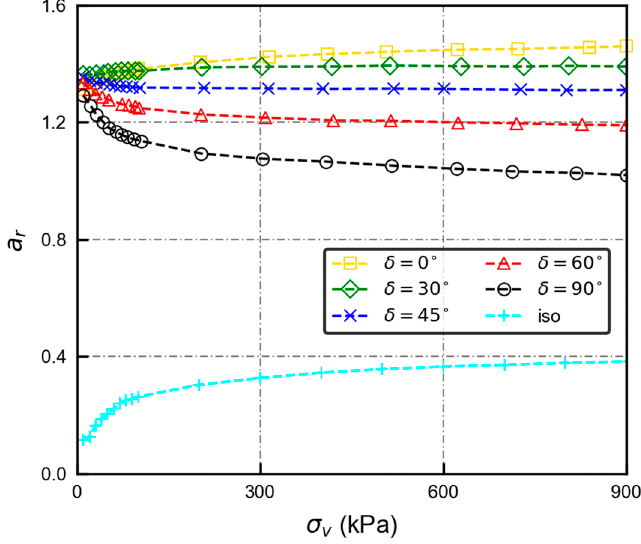
Figure 10. Evolution of a r in different initial anisotropy specimens.